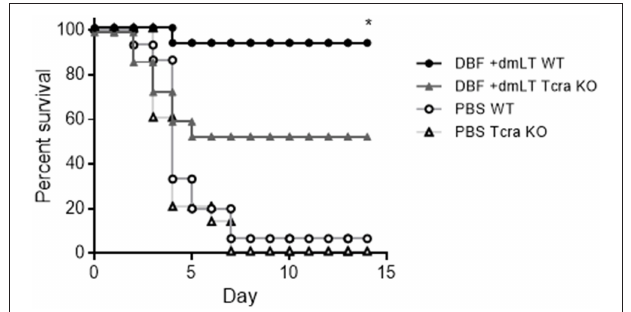
FIGURE 7 | Immunization of T cell deficient mice. Mice ( n = 15) were immunized three times at days 0, 14, and 28 before challenge with PBS or the combination DBF + dmLT intranasally,. Mice were challenged with 2 × 10 7 CFU of Shigella flexneri 2457T. Survival was monitored for 14 days. ** p < 0.01 compared to survival of KO mice vaccinated with DBF + dmLT using log-rank Mantel-Cox test.